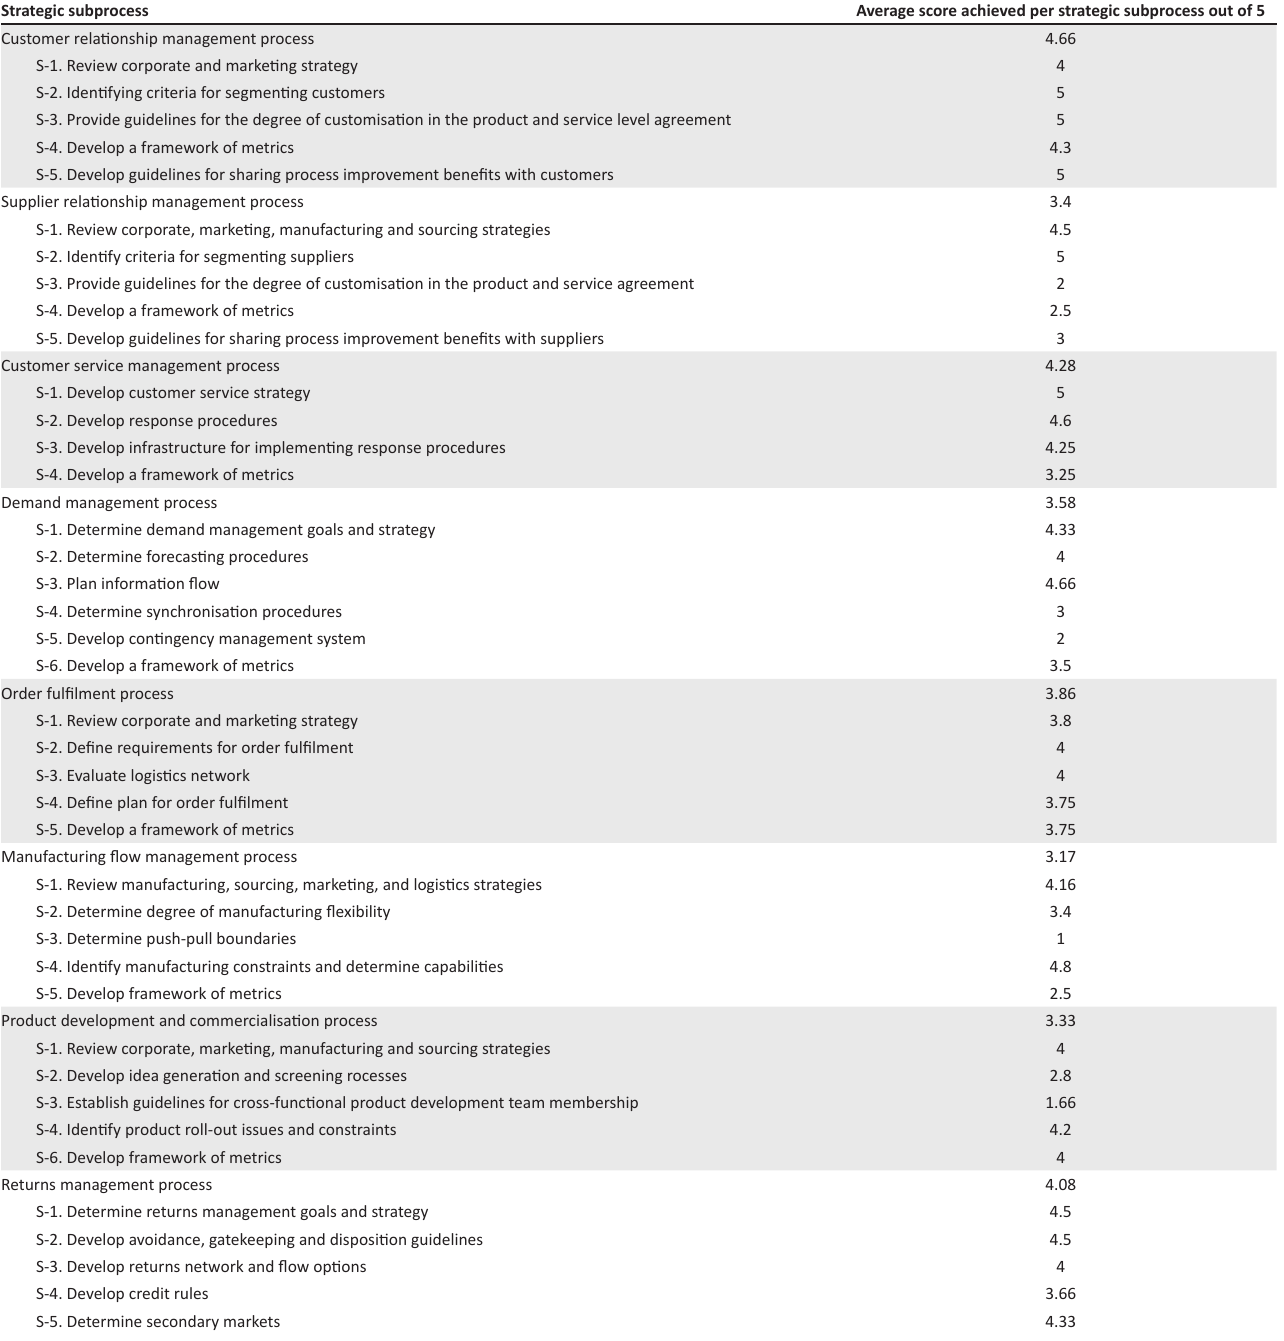
TABLE 3: Average score achieved per strategic subprocess according to the Global Supply Chain Forum benchmarking framework. Strategic subprocess Customer relationship management